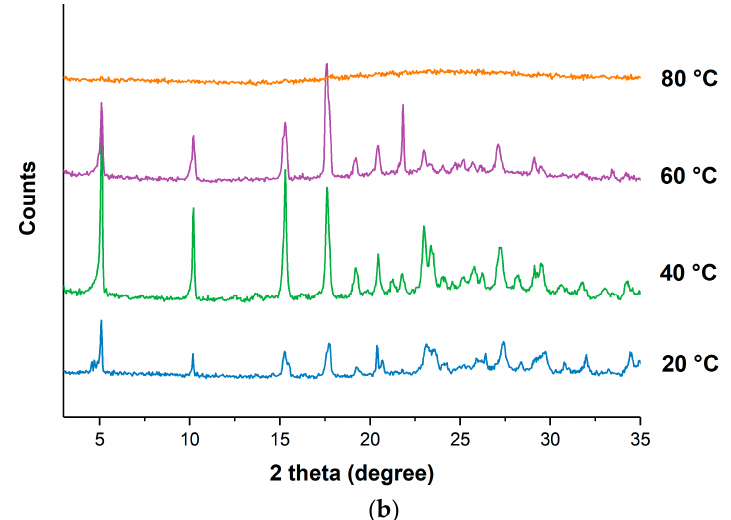
Figure 3. ( a ) Differential scanning calorimetry (DSC) thermograms and ( b ) powder X-ray diffraction Figure 3. ( a ) Di ff erential scanning calorimetry (DSC) thermograms and ( b ) powder X-ray di ff raction (PXRD) patterns of the VRC-tartaric acid (TAR) system at di ff erent annealing temperatures (t anneal = 3d). (PXRD) patterns of the VRC-tartaric acid (TAR) system at different annealing temperatures (t anneal = 3d).